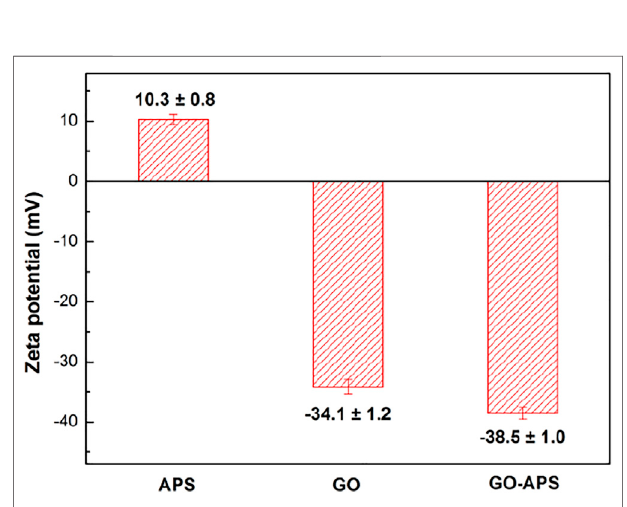
FIGURE 2 | Zeta potential ofstableand homogeneous sols: (A) APS; (B) GO; (C) GO-APS.